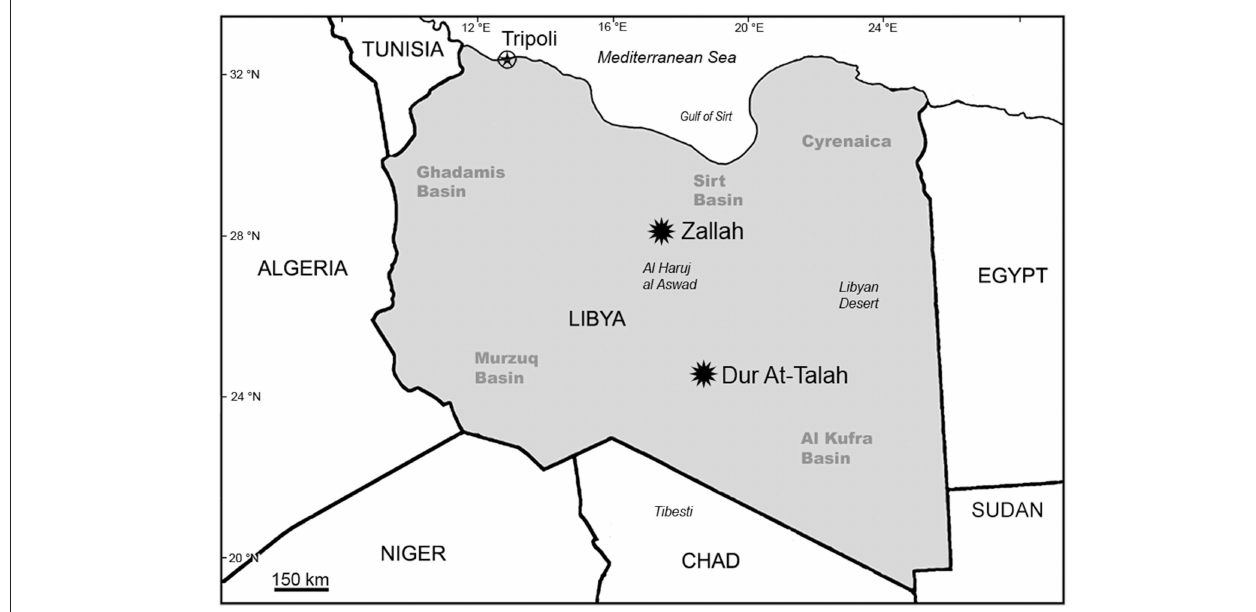
FIGURE 2 | Map of Libya and adjacent areas showing the location of Zallah Oasis and the Dur At-Talah escarpment in the Sirt Basin.